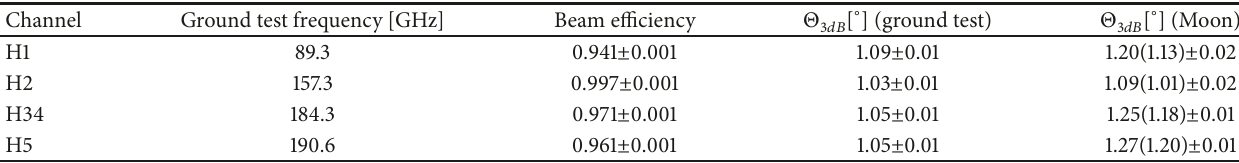
Table 1: Antenna performance—space view—centre frequencies (values from [8], except for the last column, where values were calculated for a point-like lunar emission and, in brackets, a 𝐹𝑊𝐻𝑀 𝑀𝑜𝑜𝑛 of 0.4 ∘